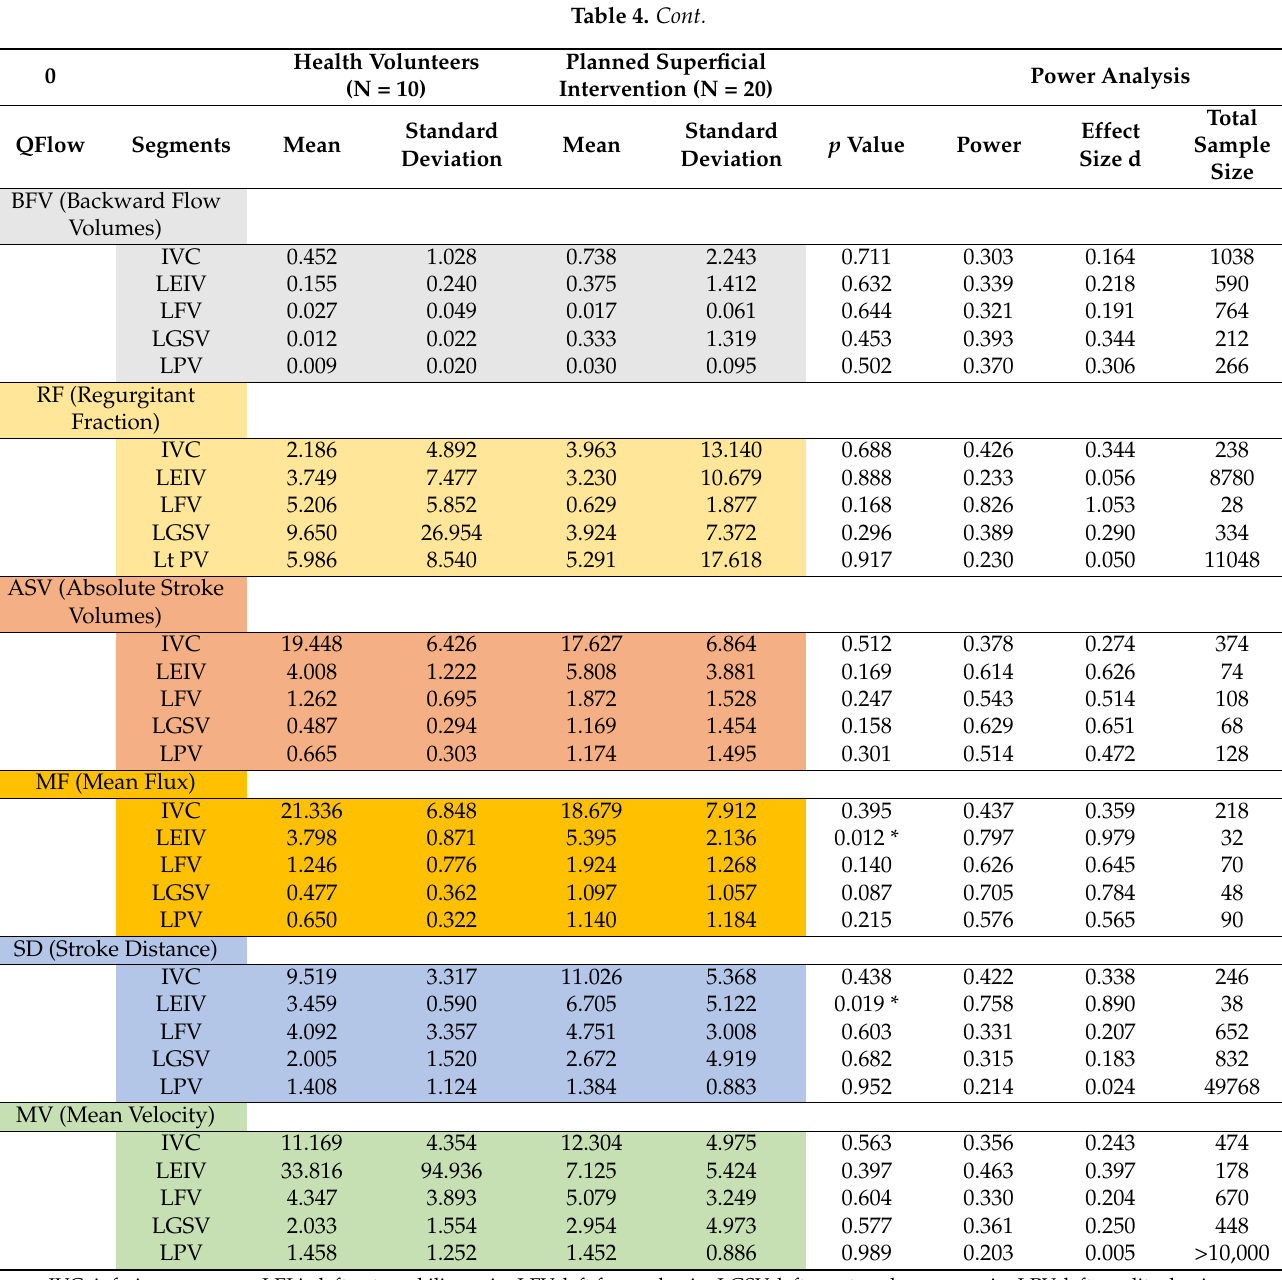
Table 5 shows the findings of the QFlow comparison of 10 patients who received inter- vention in their right leg with the right legs of 10 controls. SV ( p = 0.002), FFV ( p = 0.001), and MF ( p = 0.001) in the GSV were higher in the right-leg-intervention